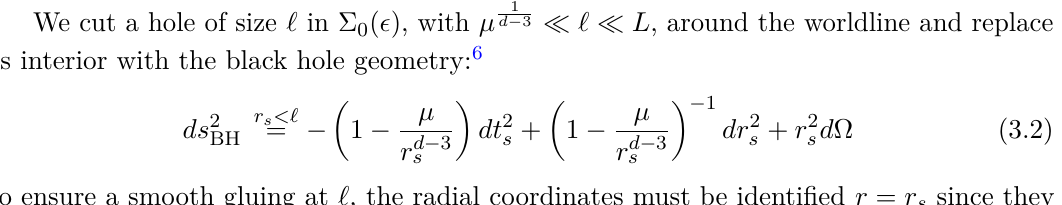
Figure 2. Our black hole is introduced geometrically by cutting a hole of size ‘ around the ideal observer’s worldline in the initial Cauchy slice and a small time band Σ the interior with a black hole metric. The local killing vector generating the worldline’s proper time is glued to the local generator of Schwarzschild time which, in turn, is modular time. As long as nothing falls in the black hole, this identification is valid everywhere along the worldline, suggesting that modular time is correlated to proper